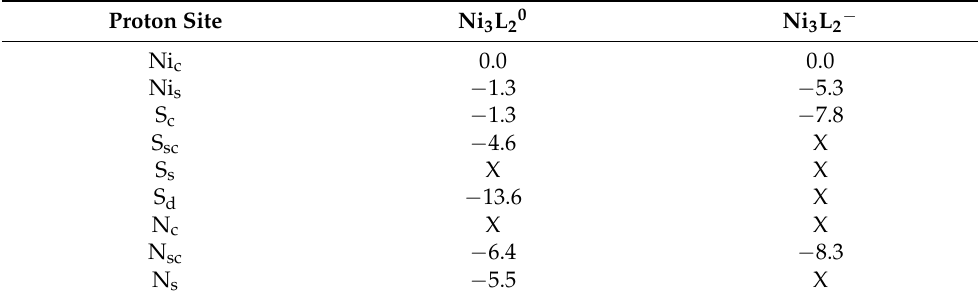
Figure 8. Spin density plots ( a , c ) and localized SOMOs ( b , d – f ) calculated for Ni 3 L 2 after subsequent one- and two-electron reduction reactions. The complex starts in its neutral, singlet state, passing through a doublet monoanionic state ( a ), and finishing as a trianion in a doublet state ( c ). Table 1. Relative pK a values for Ni 3 L 2 after the first and second reduction steps. Values are relative to the free energy of protonating the Ni c atom. ‘X’ corresponds to cases where geometry optimization of the protonated complex shows cleavage of the complex. Cleavage cases are not considered, as they will affect the ability to restore the catalyst at the end of the catalytic